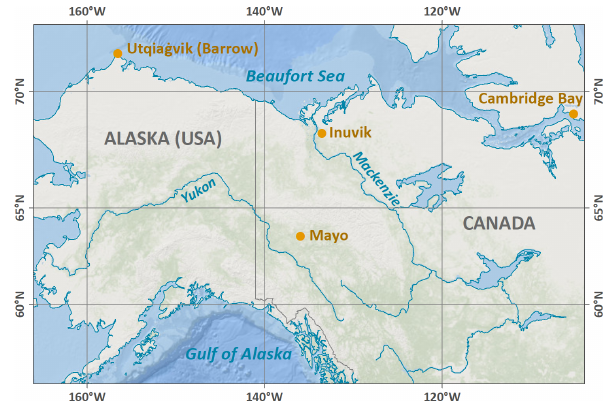
Figure 1. Map with WMO stations in the western Arctic, where GNIP data and LMWLs exist (i.e. Inuvik, Utqia˙gvik (Barrow), Mayo and Cambridge Bay). Map by Sebastian Laboor (Alfred We- gener Institute, AWI, Potsdam,